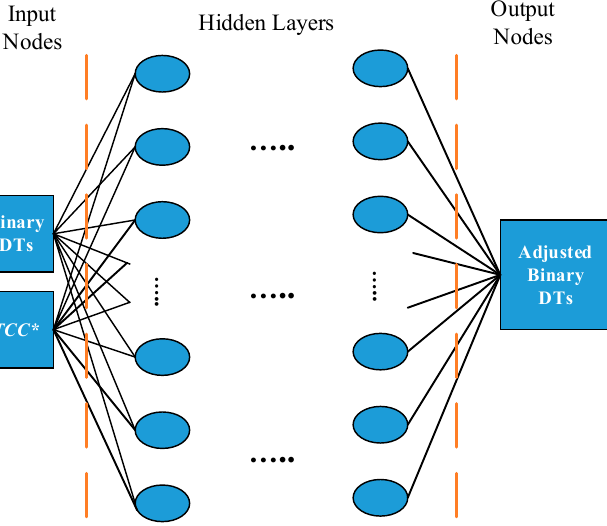
Figure 5. NNTA rule training architecture.